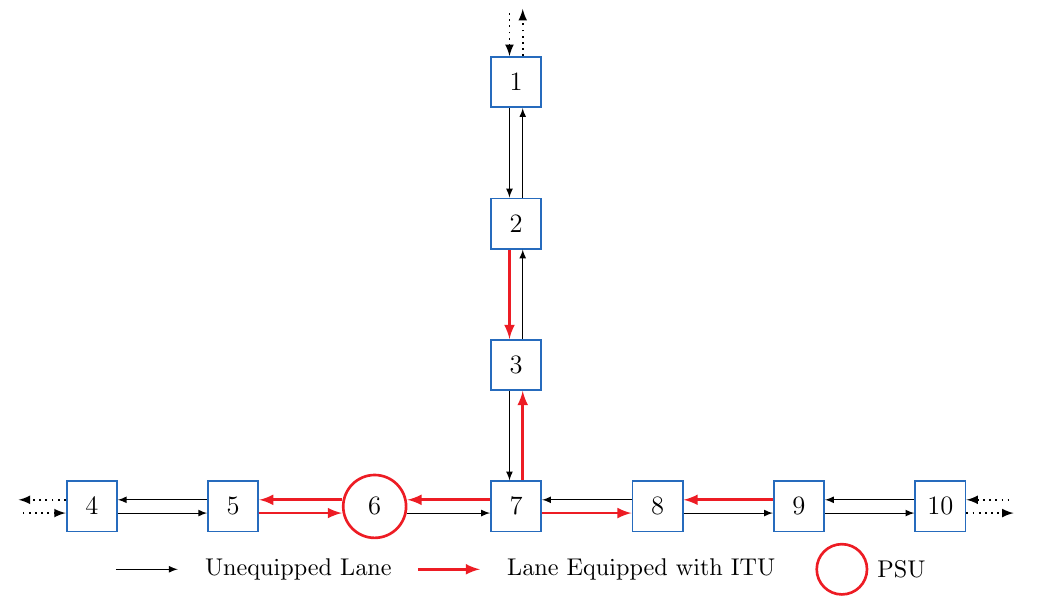
Figure 8. Selected installation positions for Inductive Transmitter Units (ITUs) connected to a common Power Supply Unit